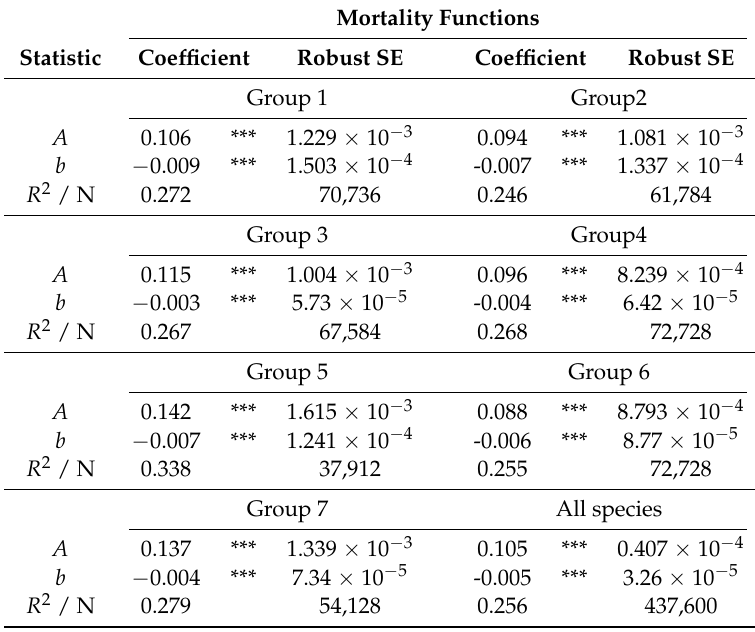
Table 5. Parameters of the mortality probability functions by group of species ( 1 ) .